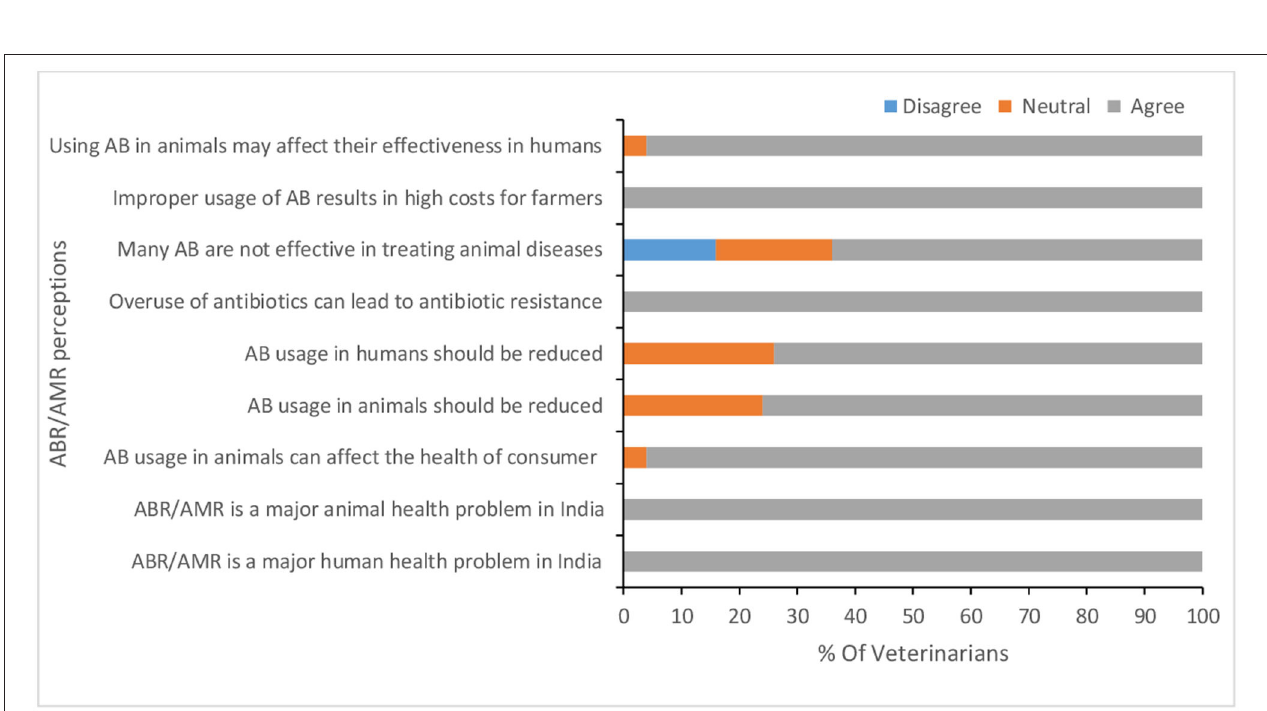
FIGURE 5 | Veterinarians’ perceptions of antibiotic resistance/antimicrobial resistance (AMR).